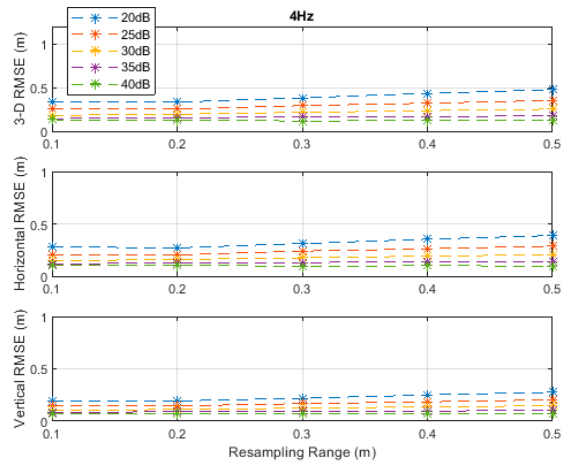
Figure 3. RMSE results along the 3D linear path at a measurement update rate of 2 Hz.